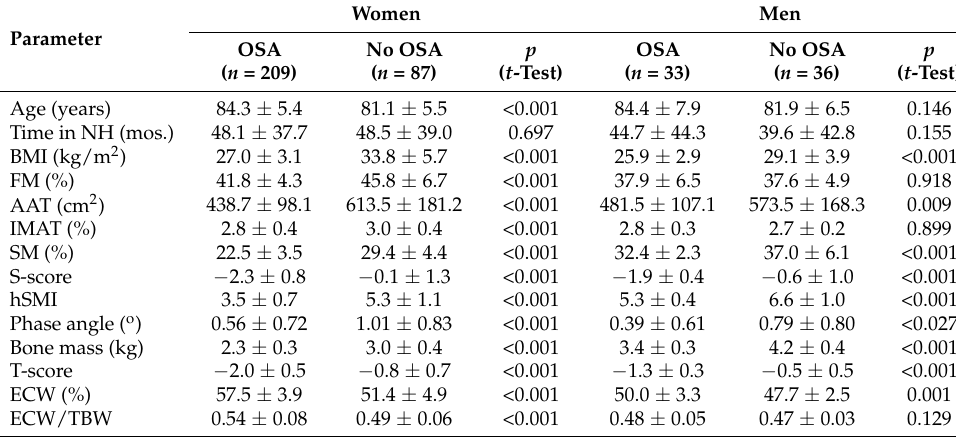
Table 2. Differences in age, time in nursing home, and body composition parameters in women and men according to OSA